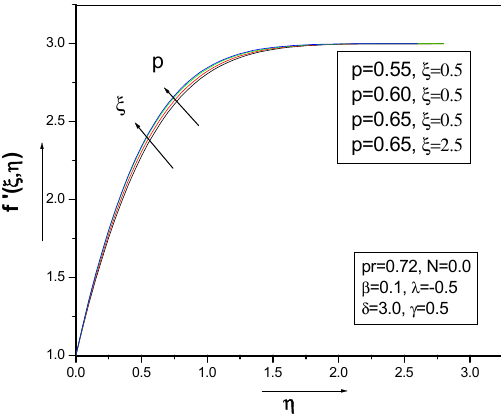
Figure 9. Effect of the velocity exponent parameter on velocity profile.